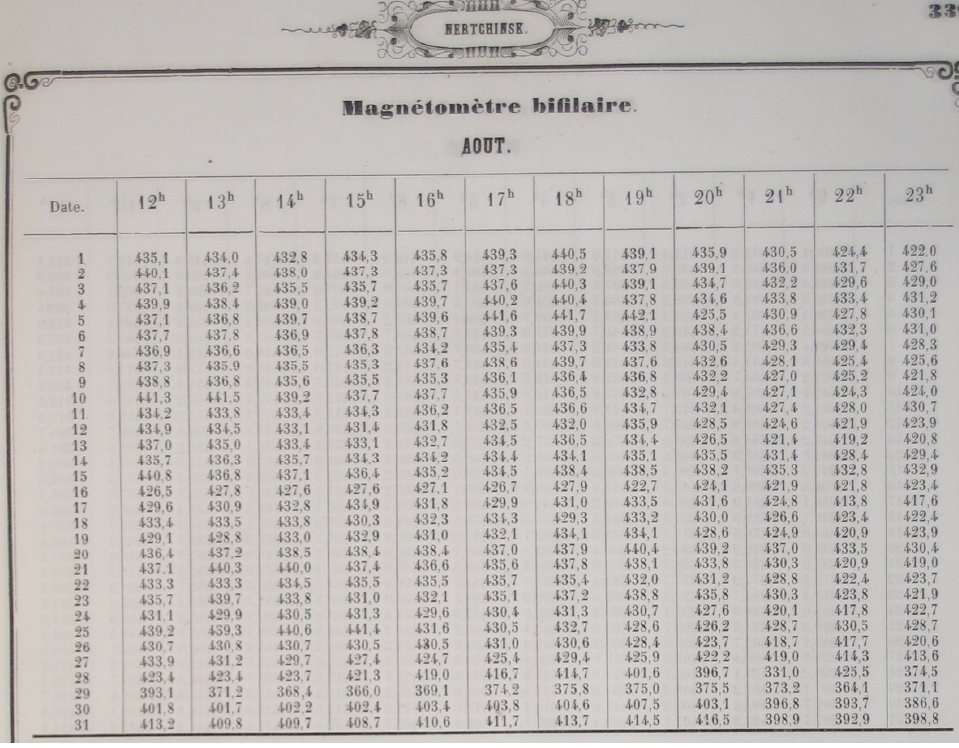
Fig. 2. An example of a part of a yearbook data table. The page is for H-component (Magn´etom´etre bifilaire) from the observatory Nertchinsk August 1859 showing data from 12:00h to 23:00h (00:00h–11:00h local time). The column on the left gives the dates. Hours are shown on the upper row. Other columns give observed instantaneous hourly values of H in units of 1/24 inch (roughly 1mm) taken from the